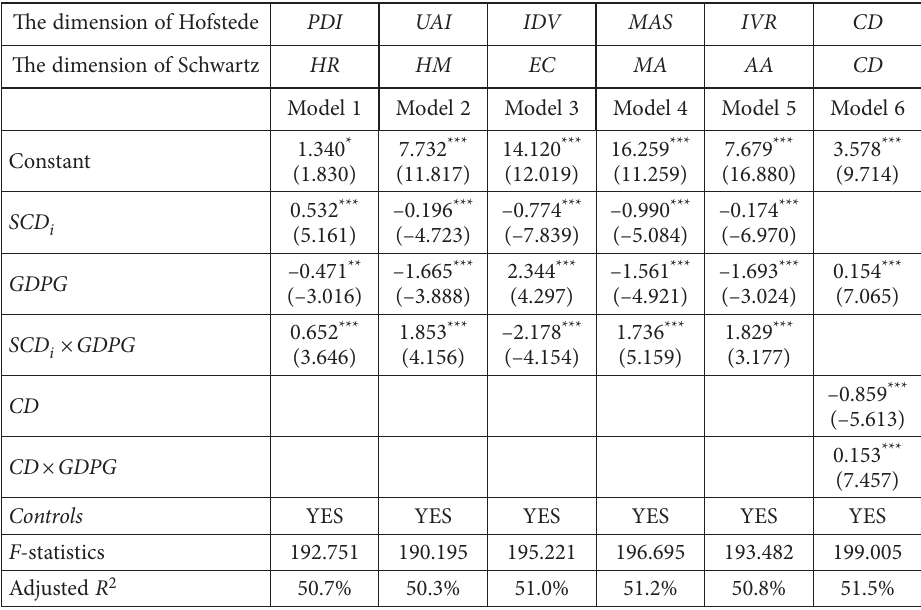
Table 9. The moderating effect of economic growth on Schwartz cultural dimensions and IPO under- pricing (source: authors’ calculation) The dimension of Hofstede PDI The dimension of